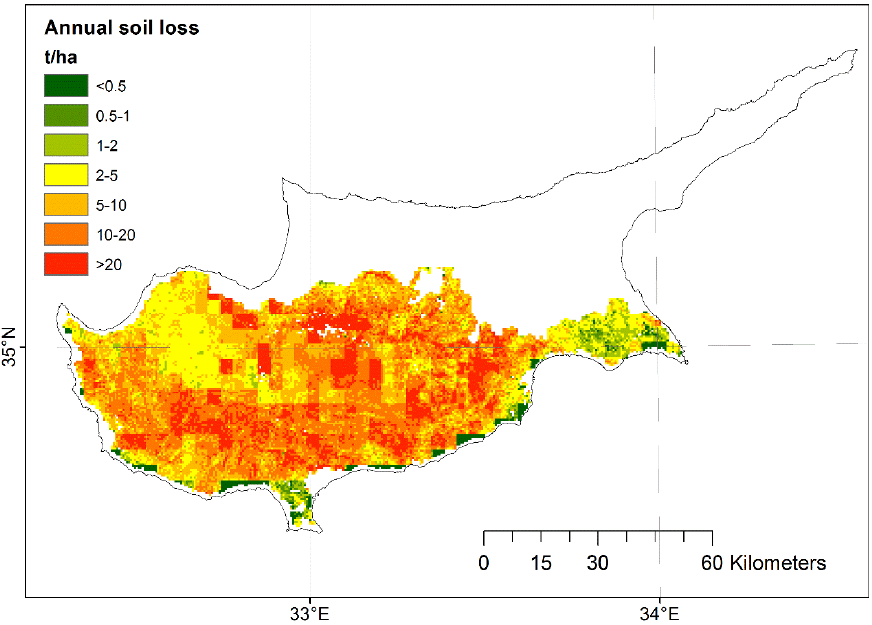
Figure 4. The annual soil loss map of Cyprus (cell size: 100 m; value ranging: user defined).